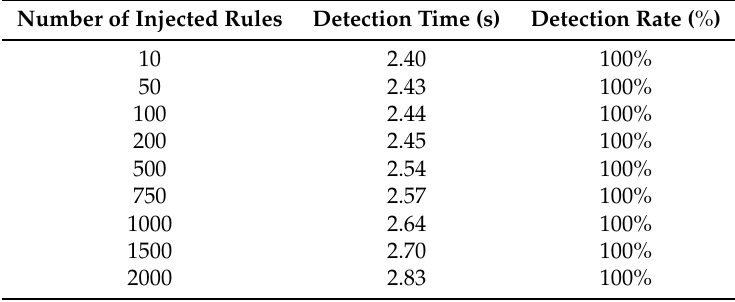
Table 9. Detection performance of BICS.